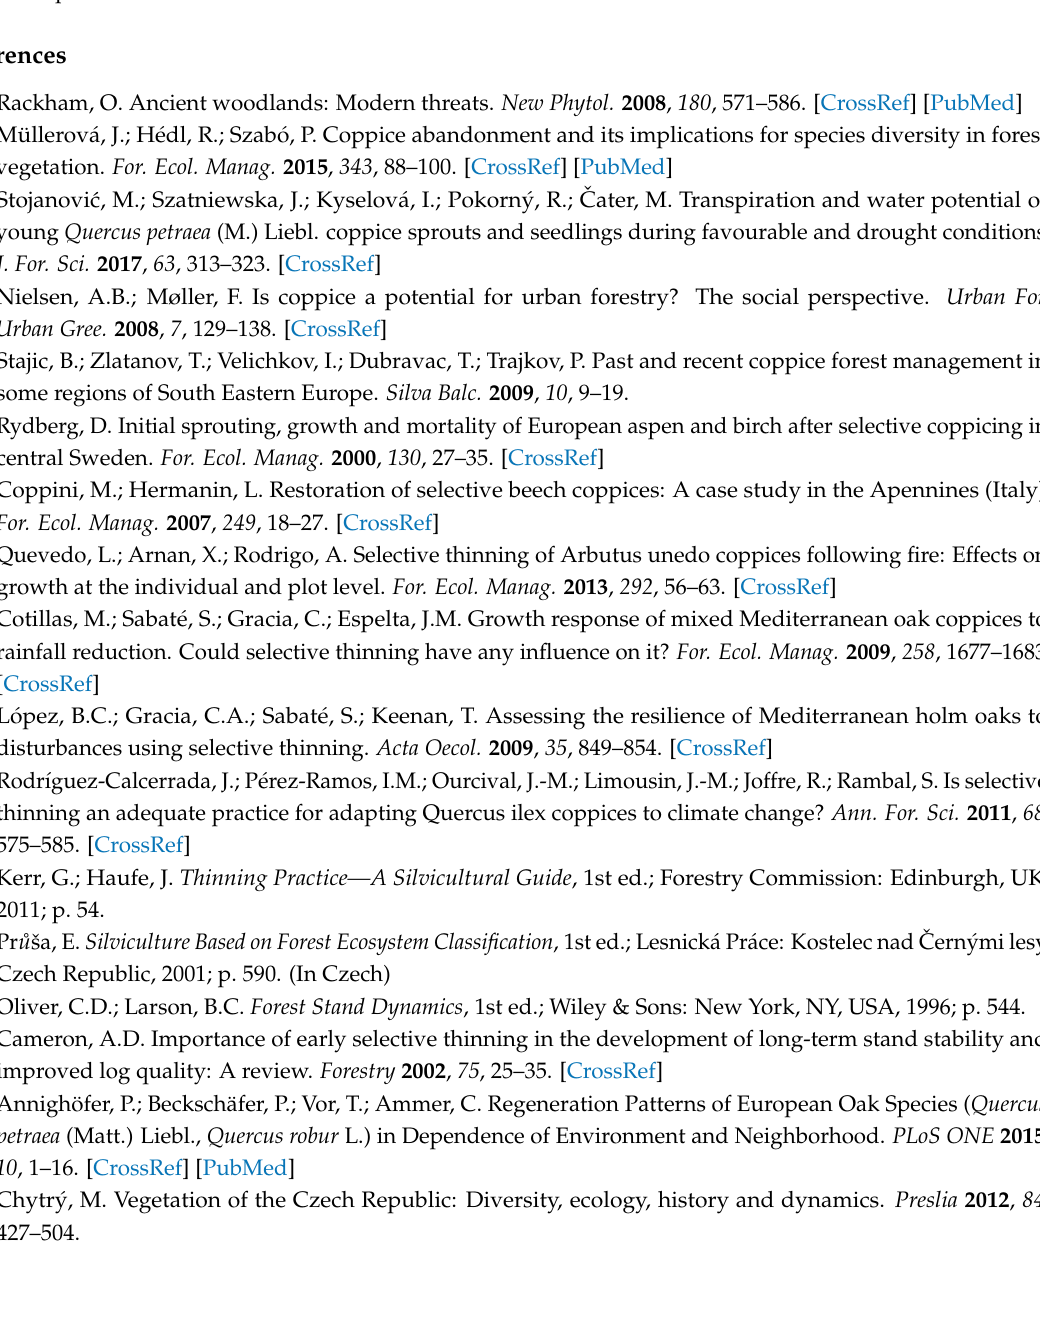
Table S1: The goodness of fit characteristics of the number of live new sessile oak sprouts model, Table S2: The goodness of fit characteristics of the number of live new European hornbeam sprouts model, Table S3: The goodness of fit characteristics of the number of dead new sprouts model, Table S4: The goodness of fit characteristics of the new sprouts height